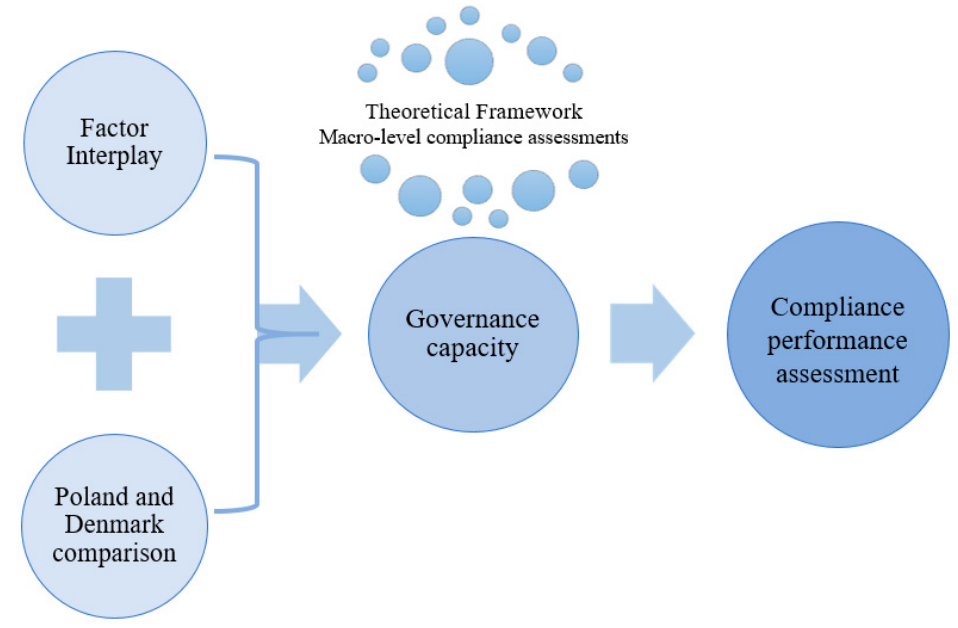
Figure 4. Phase 2: Compliance performance assessment.